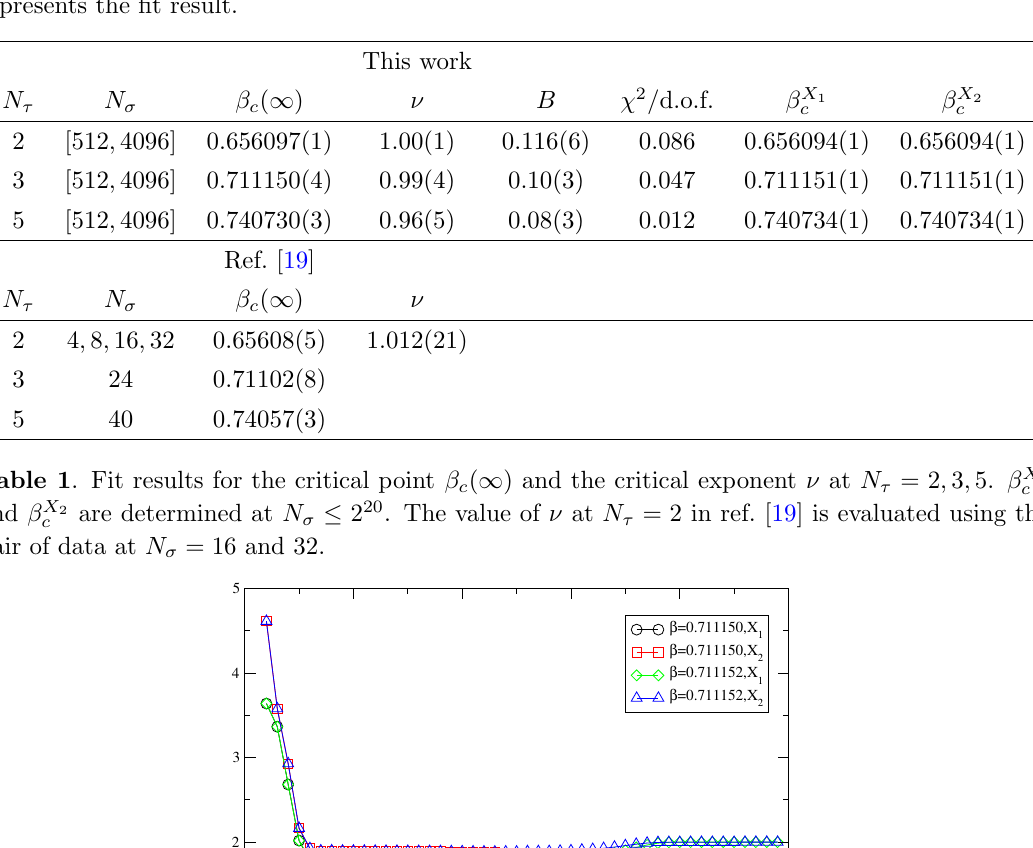
Figure 11 . X 1 and X 2 above and below the transition temperature as a function of TRG steps at N (cid:28) = 3.